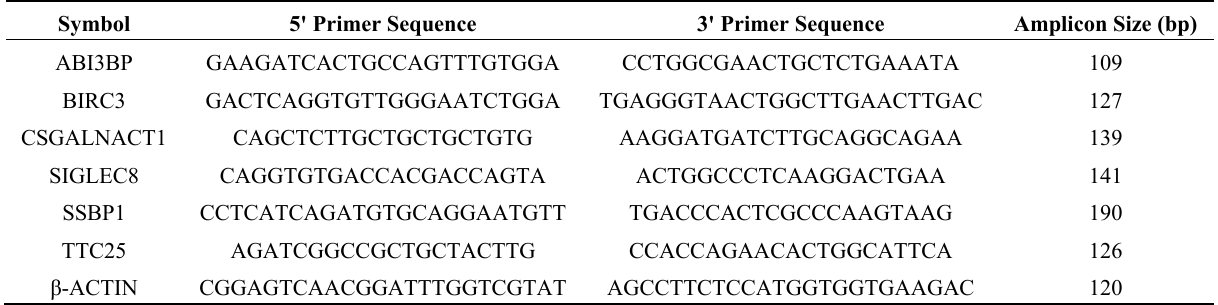
Table 5. Primers used in qRT-PCR validation of the microarray